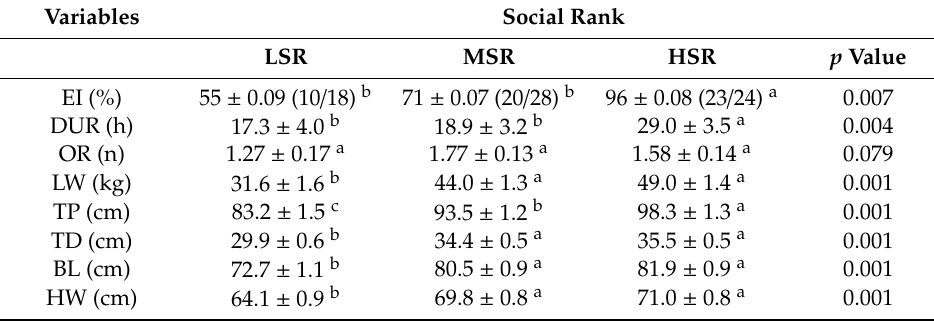
Table 1. Least-square means ± standard error for estrus induction (EI, %), duration of estrus (DUR, h), ovulation rate (OR, n), live weight (LW, kg), thoracic perimeter (TP, cm), thoracic diameter (TD, cm), body length (BL, cm), height at the withers (HW, cm), beard (BEA, cm), compactness index (COM, units), and anamorphosis index (ANA, units) according to social rank (i.e., LSR, MSR and HSR), and eCG dose (i.e., 100 or 350 IU) in crossbred (Alpine-Saanen-Nubian × Criollo; n = 70) dairy goats managed under intensive conditions in Northern Mexico (March, 25 ◦ North) 1,2